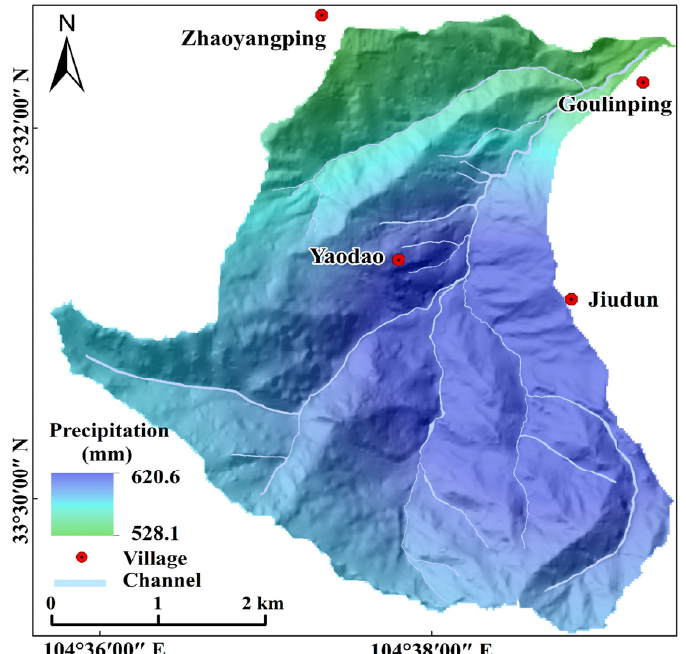
Figure 3. Spatial distribution of rainfall in the GLP.